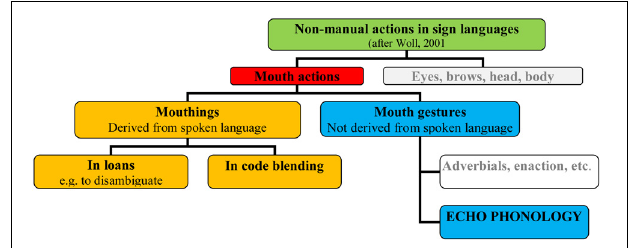
FIGURE 1 | Mouth actions in sign language.